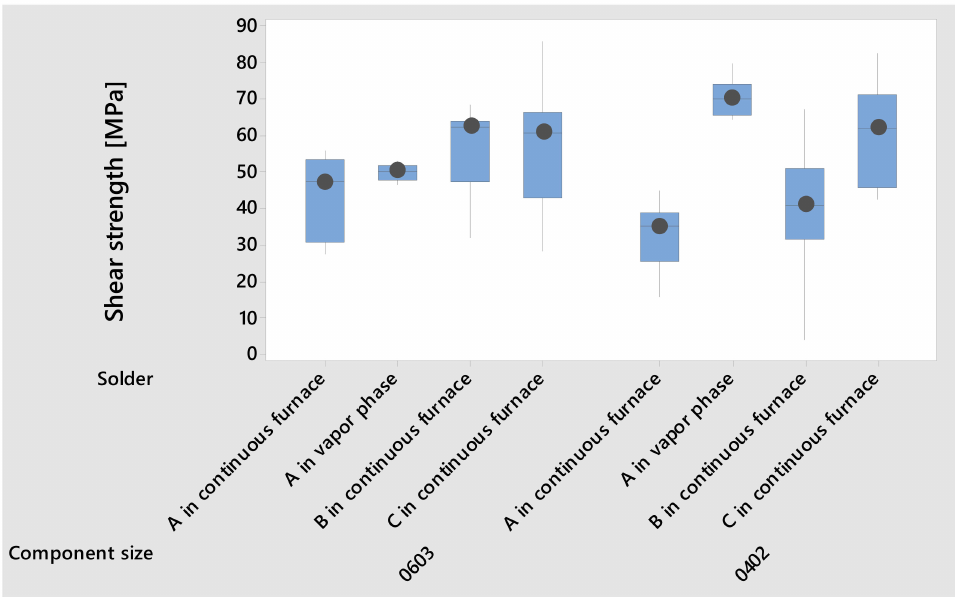
Figure 6. Shear strength of the soldered SMDs on the polyimide foil for the process variation.